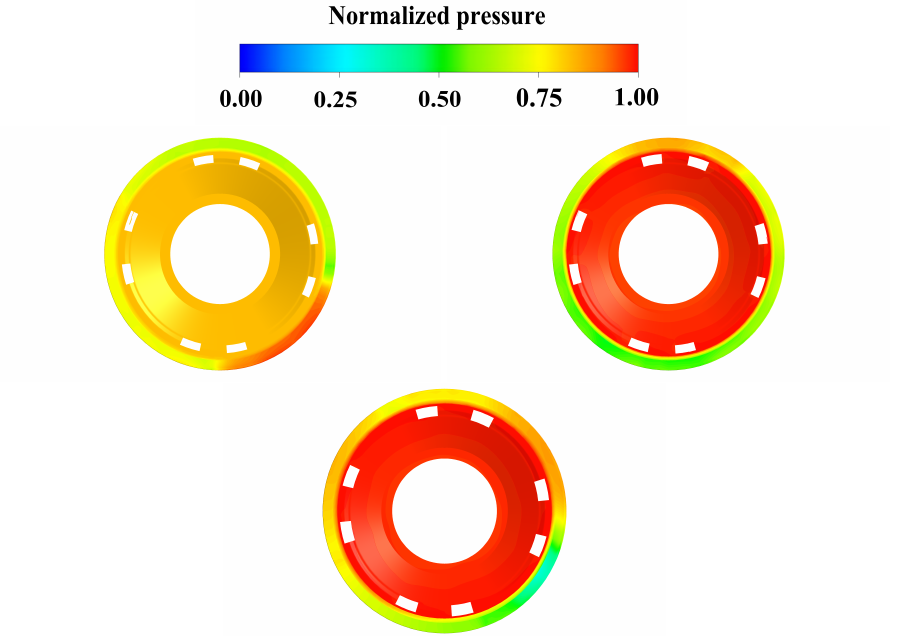
Figure 7. Pressure distributions of the crown chamber with the 0.5 mm ( top-left ), 1.5 mm ( top-right ), and 2.5 mm ( lower ) radial installation deviation models with